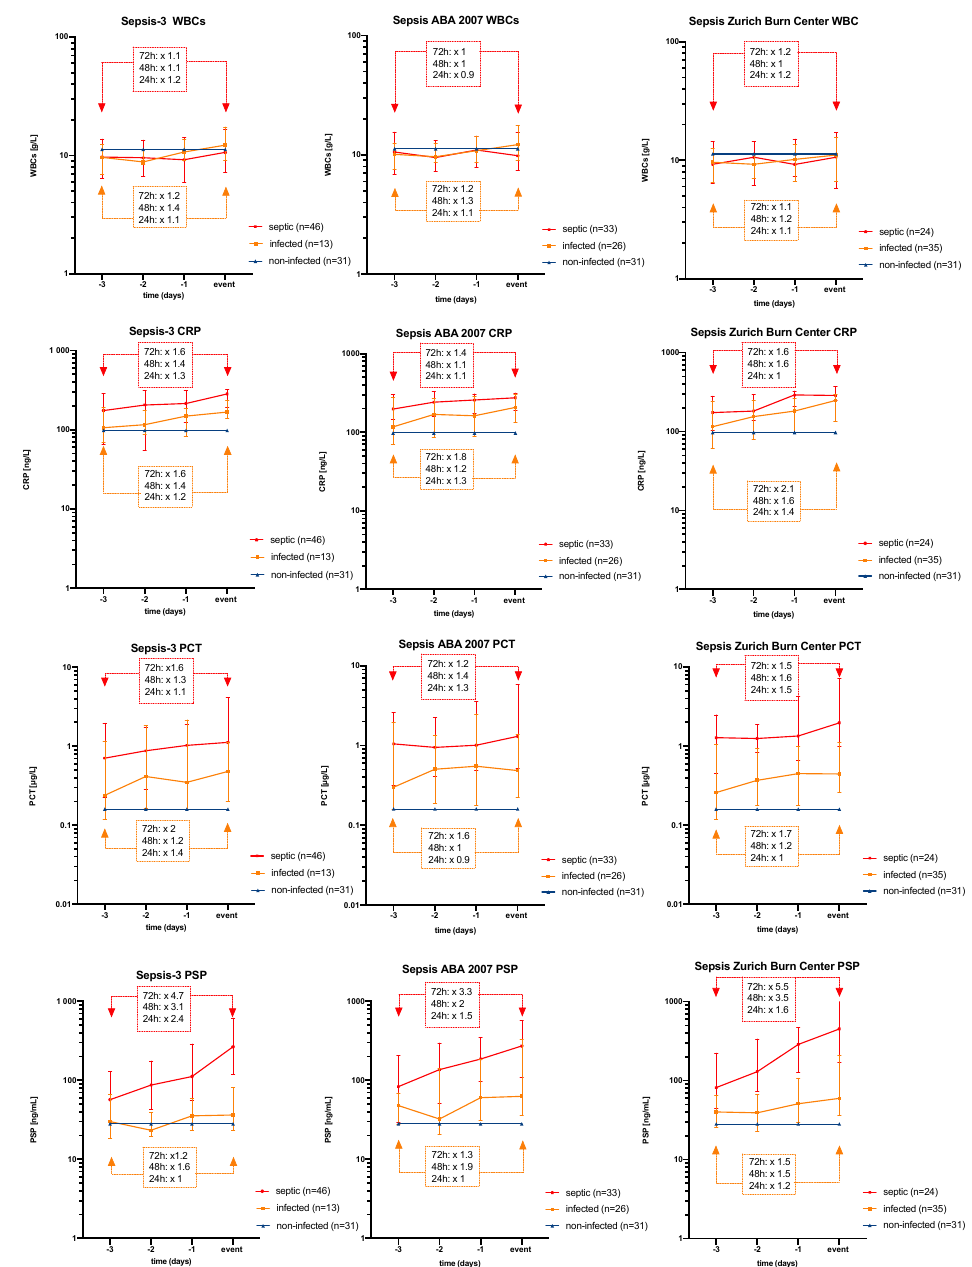
Figure 4. Time course of the biomarkers as related to the event of sepsis. White blood cell (WBC), C-reactive protein (CRP), procalcitonin (PCT), and PSP time courses are shown in single plots for each sepsis definition. Whereas leukocytes, CRP, and PCT showed only mild alterations, PSP consistently demonstrated a steep increase for septic patients up to 72 h before sepsis was diagnosed across all three definitions.